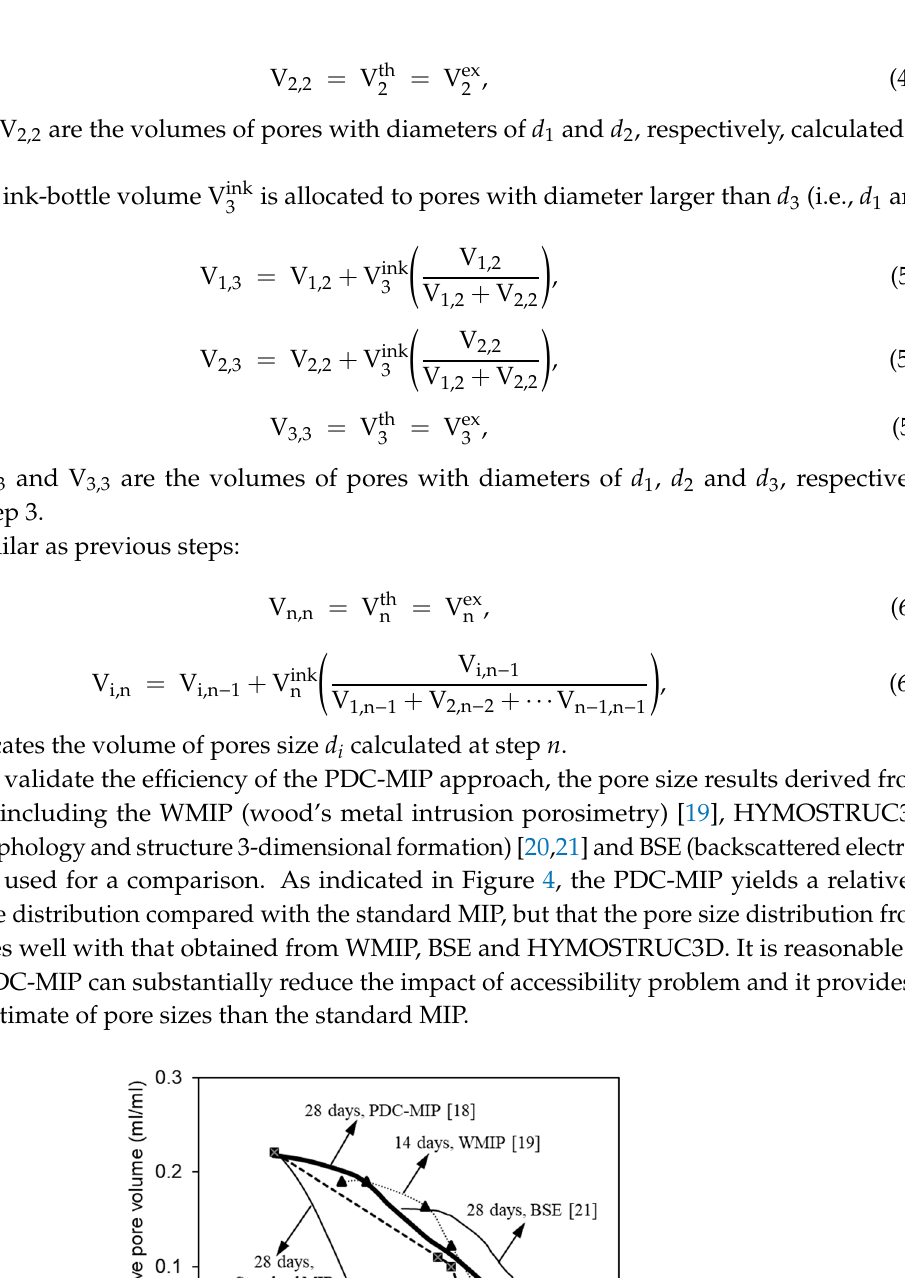
Table 1. Mix proportions of paste samples (weight percentage) with ordinary Portland cement (OPC), fly ash (FA) and limestone powder (LP). Mixtures